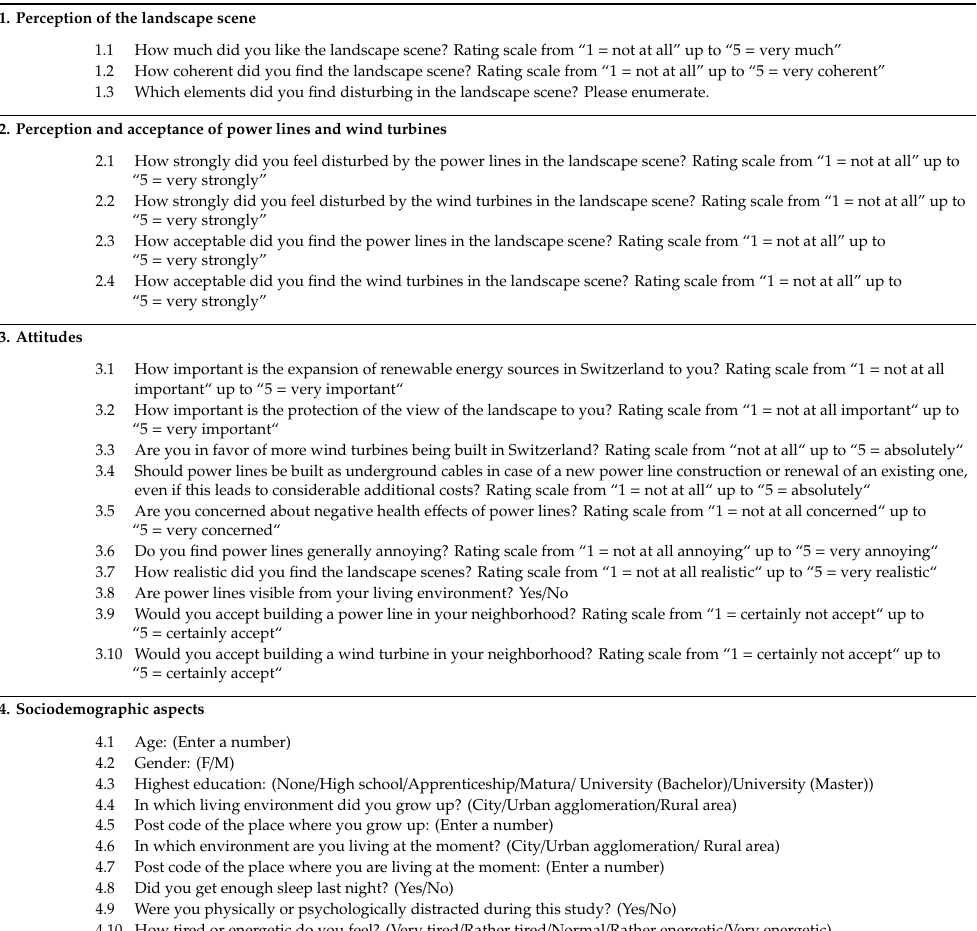
Table 1. Questions of the survey asked during guided perception (1), without eye tracking after the landscape perception (2), and at the end of the study